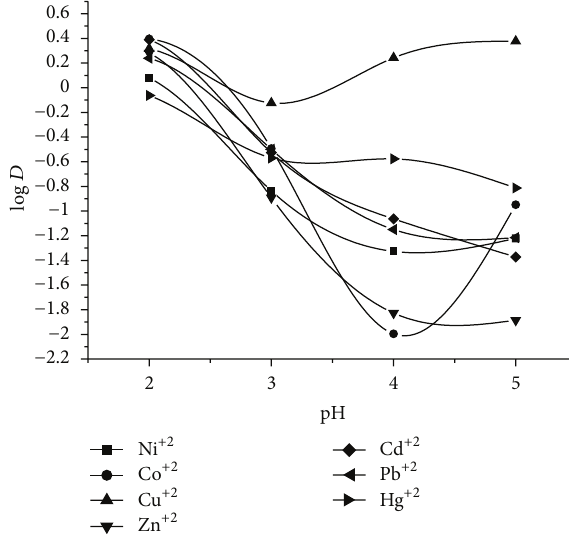
Figure 2: pH-log 𝐷 graph of L1